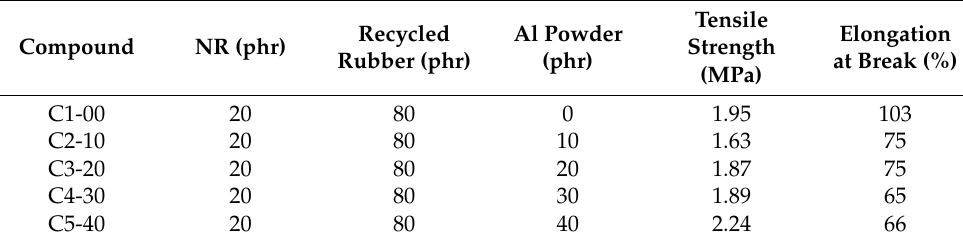
Table 4. Weight percentage of the recycled rubber reinforced polymer composites filled with alu- minum powder [31].